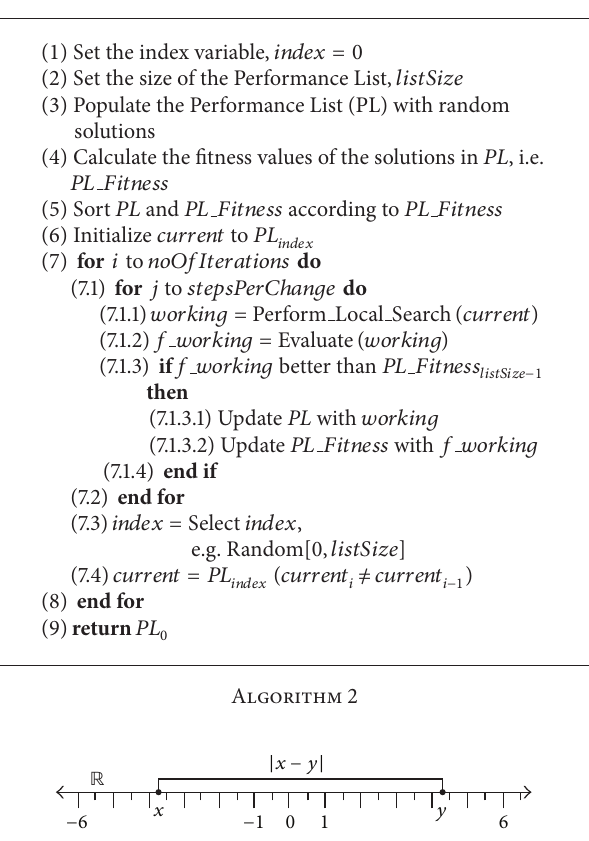
Figure 1: The absolute difference between the values 𝑥 and 𝑦 .